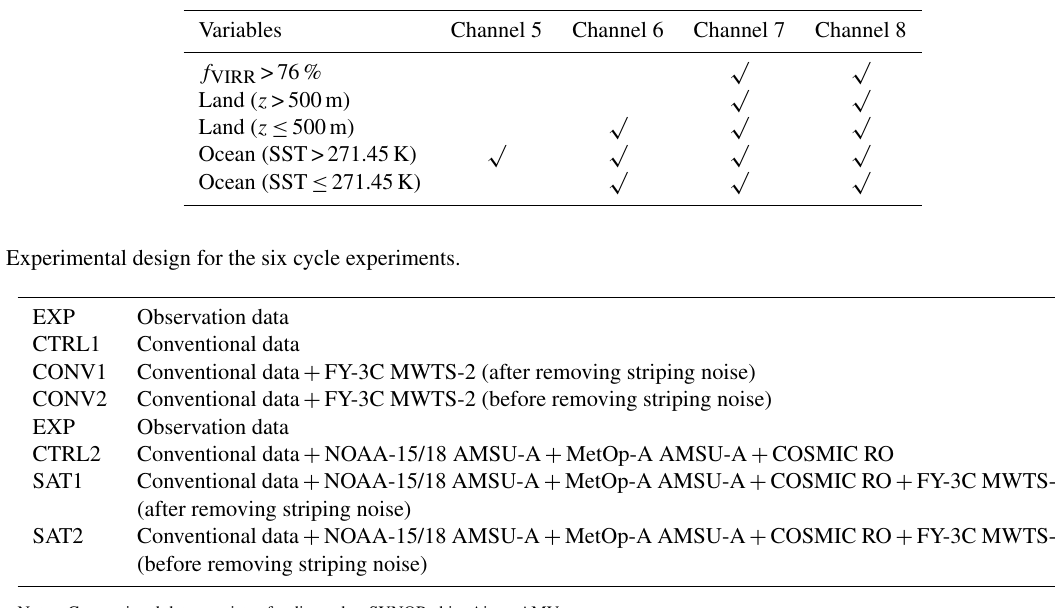
Table 2. Channel selection based on cloud fraction, terrain height ( z) , and surface types. Variables